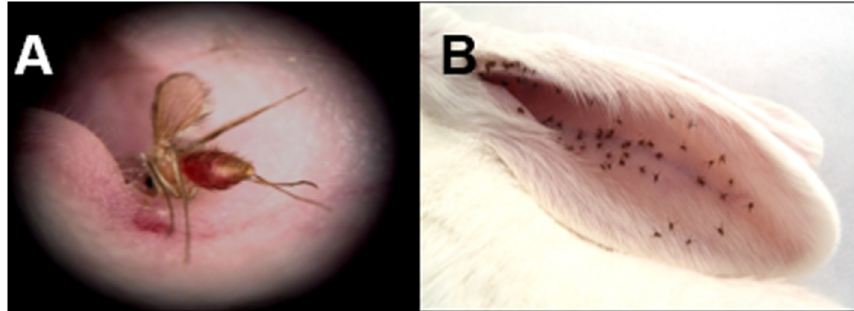
Fig 2. Detailed pictures of the immunization process. Female P . perniciosus feeding on the ear of anesthetized animals. ( A) Mouse. ( B) Rabbit.